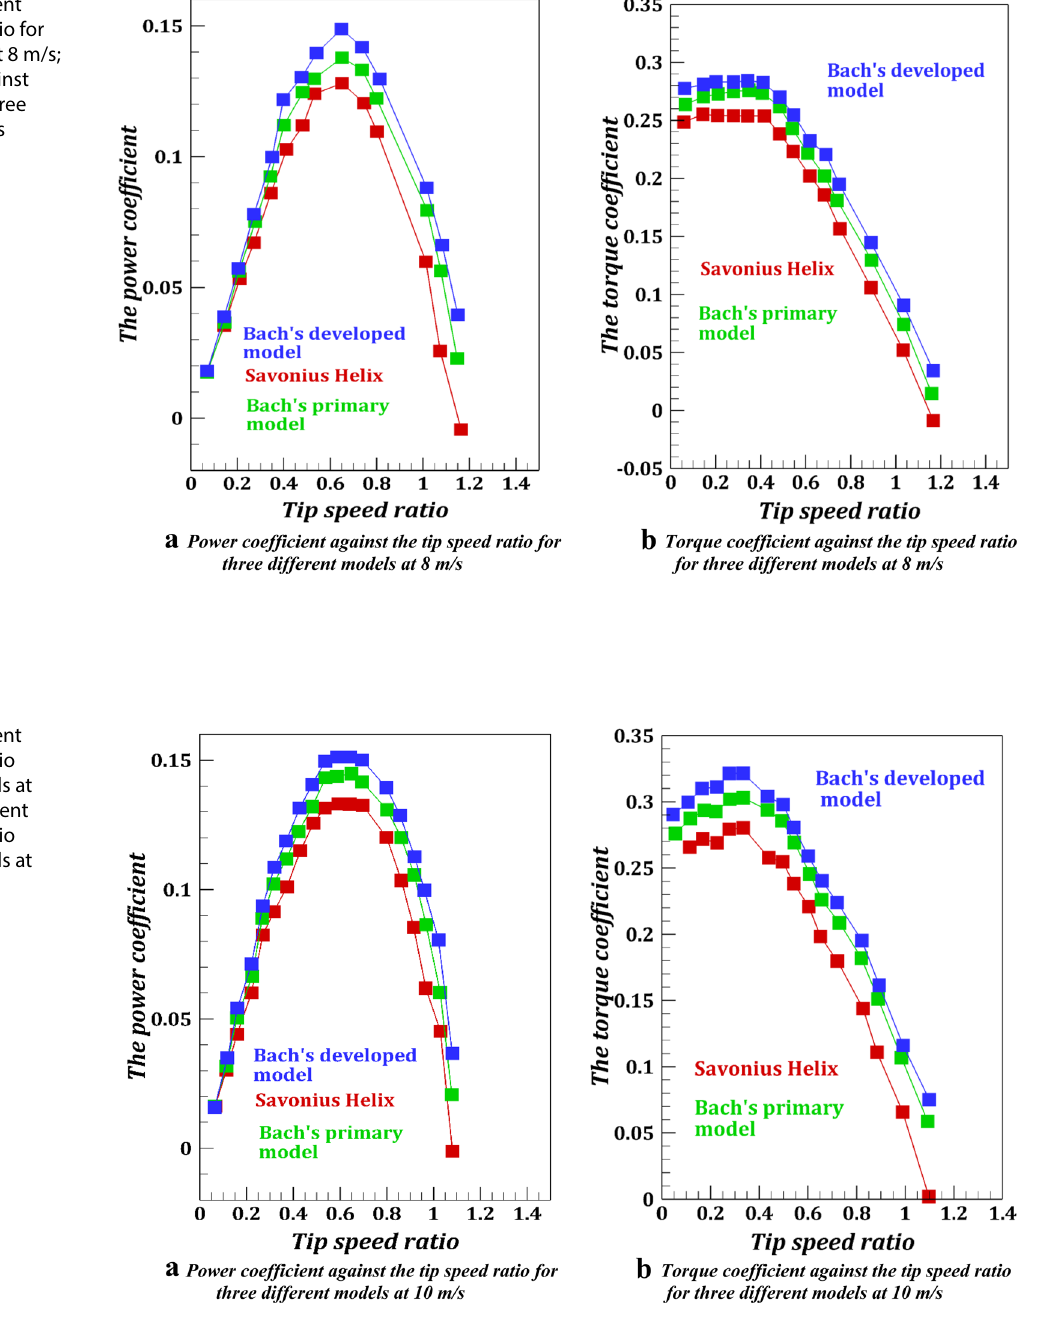
Fig. 10 a Power coefficient against the tip speed ratio for three different models at 8 m/s; b Torque coefficient against the tip speed ratio for three different models at 8 m/s